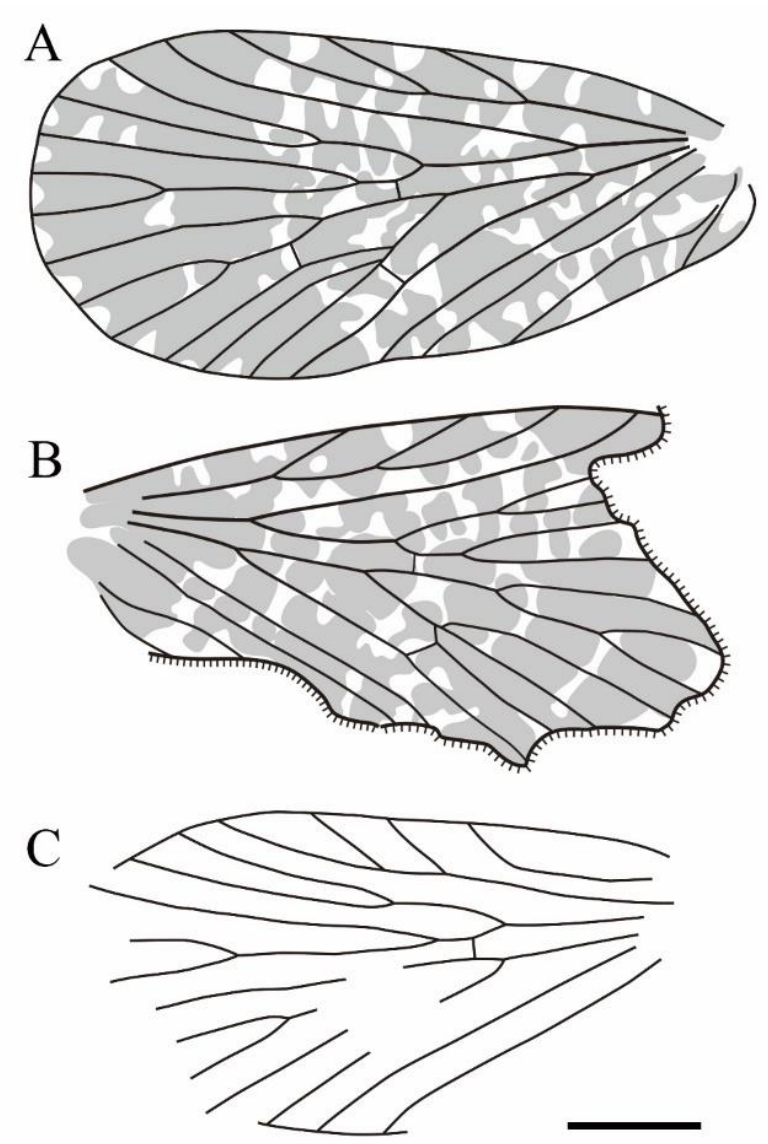
Figure 11. Line drawing of Sinoagetopanorpa elegans sp. nov., NIGP200921 (holotype). ( A ) Line drawing of one forewing; ( B ) Line drawing of the other forewing; ( C ) Line drawing of one hind wing, dark color not illustrated. Scale bar represents 1 mm. Hind wing poorly preserved with dark color; costal area broad, ca. 3 times as wide as subcostal area; Sc abruptly curved to costa apically; R 1 forking near the same level as apical Sc; Rs five-branched, Rs 4 bifurcated into two branches, one hind wing with stem Rs 1+2 slightly longer than Rs 3+4 , the other hind wing with Rs 1+2 nearly twice as long as stem Rs 3+4 ; Rs 4a+b fork distinctly distad to M 2a+b fork; a crossvein connecting stem Rs 3+4 and stem M 1+2 ; M five-branched, M 2 with two branches, stem M 1+2 longer than stem M 3+4 ; CuA and CuP single and straight, anal veins